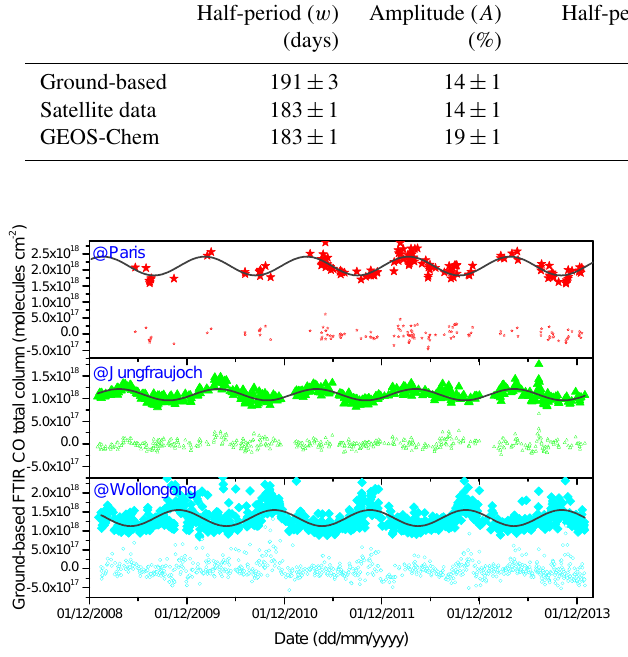
Figure 2. Time series of CO columns from satellite instruments and ground-based FTIR are given for Paris, Jungfraujoch and Wollon- gong (from top to bottom). IASI–MetOp and MOPITT columns are displayed as black open squares and blue open circles. Ground- based FTIR CO total columns are shown by red stars, green tri- angles and cyan diamonds for Paris, Jungfraujoch and Wollongong respectively. GEOS-Chem CO total columns are indicated by black full